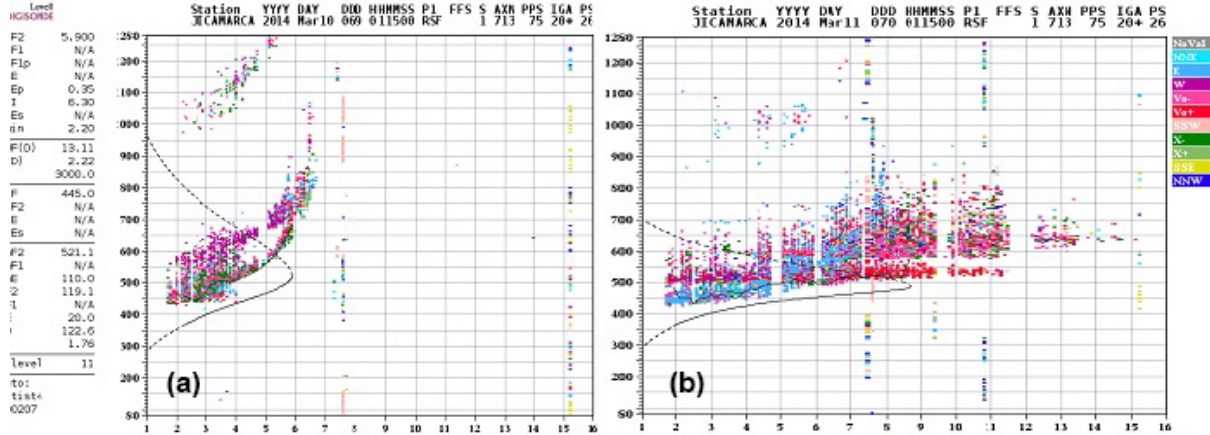
Figure 2. Sample of the RSF (a) and SSF (b) recorded using the DPS-4 digisonde at the Jicamarca station.